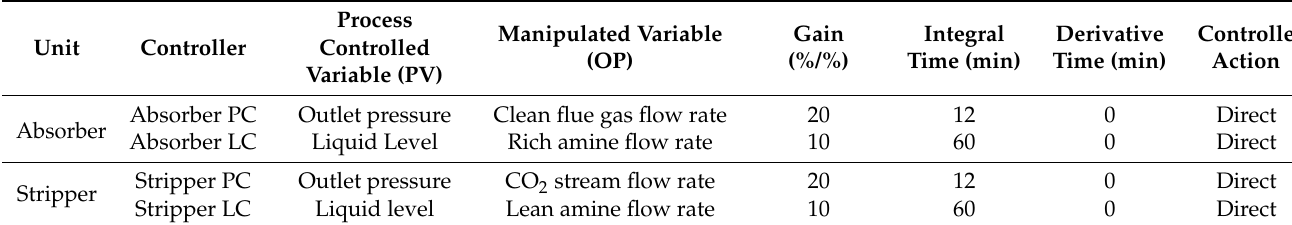
Table 4. Summary of the unit default